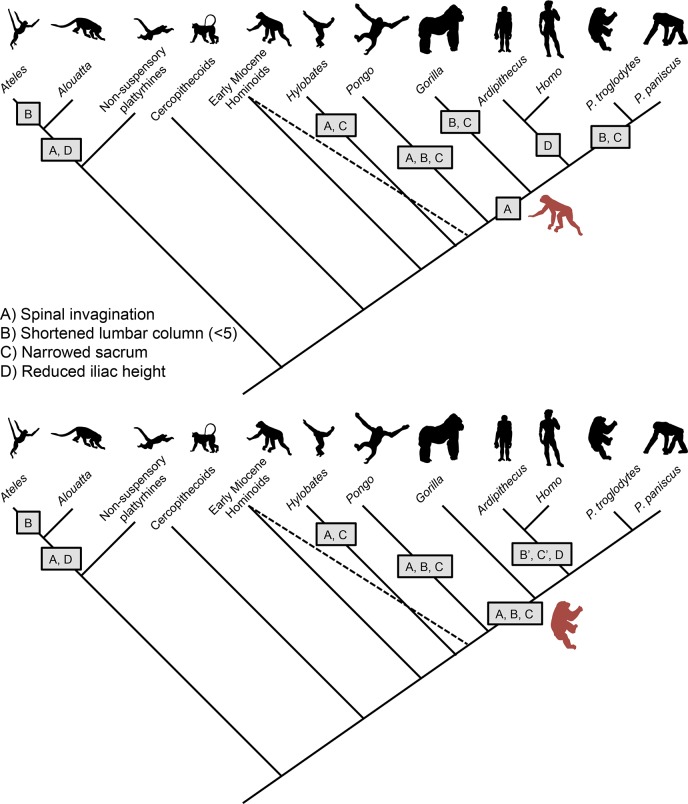
Models depicting the evolution of the lumbar column, sacrum, and ilium in hominoids.(Top) Early Miocene hominoids such as Ekembo had an uninvaginated spine, long lumbar columns (≥6 vertebrae), wide sacrum, and tall iliac height (sacral promontory/iliac crest distance) similar to other generalized catarrhines. The presence of Eurasian Miocene hominoids with ancestral morphologies (indicated by dashed line) suggests that gibbons and orangutans invaginated their spines (A) and narrowed their sacra (C) in parallel. The orangutan lumbar column length was further shortened to 4 elements (B). Shared morphologies between African apes, humans and Ardipithecus (i.e., reduced retroauricular portion of the pelvis) indicate spinal invagination and broader thorax with dorsally placed scapula were characteristic of the ancestors of the African ape clade. However, the lack of derived suspensory features in arboreal Ardipithecus, suggests that the LCA retained a long lumbar column and wide sacrum. Thus, lumbar reduction (B) and sacral narrowing (C) occurred in parallel among African apes, and iliac height reduction (C) occurred in early hominids (5 transitions) as an initial adaptation for bipedality. In New World monkeys, similar morphologies evolved in parallel with spinal invagination(A) and reduced iliac heights (D) occurring in the common ancestor of atelids, with lumbar column reduction occurring in spider monkeys (B) and muriquis (not shown). (Bottom) An alternative model posits that the African ape and human LCA had already evolved numerous suspensory and vertical climbing specializations including spinal invagination (A), lumbar reduction (B) and sacral narrowing (C). In such a case, lumbar length (B’) and sacral width (C’) would have reversed in early hominids. Both models provide similar numbers of evolutionary transitions. Note that our depiction of these models does not include the additional transitions to 6 post-transitional vertebrae in Australopithecus and a return to 5 in humans nor potential parallel lumbar shortening in chimpanzees and bonobos (McCollum et al., 2010).